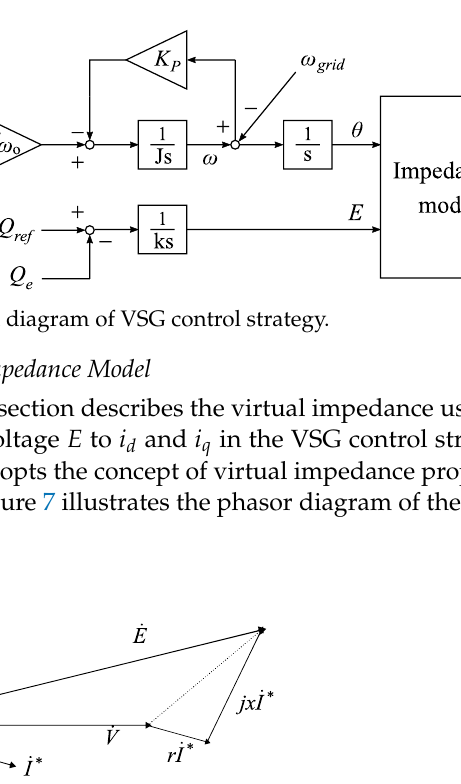
Figure 7. Phasor diagram of virtual synchronous